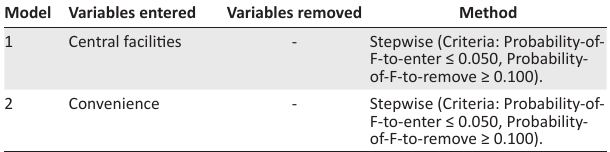
TABLE 2a: Stepwise linear regression results: Variables entered or removed a . Model Variables